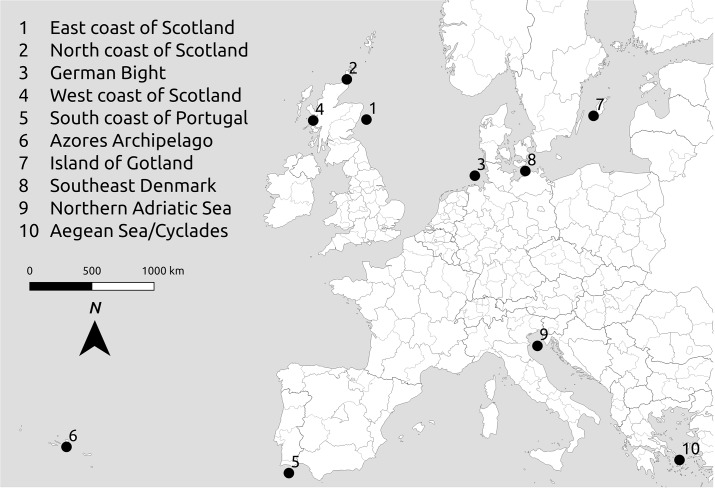
Geographical location of the 10 case studies (background map data from OpenStreetMap contributors).Case study 1 [27]; Case study 2 [28], [29]; Case study 3 [30]; Case study 4 [31]; Case study 5 [32]; Case study 6 [33]; Case study 7 [34]; Case study 8 [35]; Case study 9 [36]; Case study 10 [37].